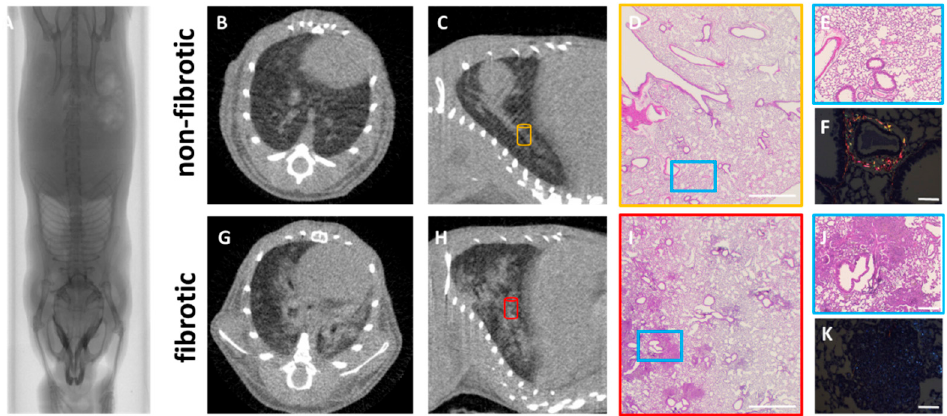
Figure 2. Overview of the use of μ CT and histology in a pre-clinical setting in a silica-induced lung fibrosis mouse model. Mice were oropharyngeally instilled with crystalline silica particles (5 mg/mouse, bottom row) or saline (top row). Whole-body μ CT scan showing the lungs of a mouse instilled with silica to induce fibrosis ( A ). Axial ( B , G ) and sagittal ( C , H ) views of non-fibrotic and fibrotic lungs. Lung fibrosis is confirmed using histology at low magnification (12.5×—scale bar 2 mm) ( D , I ) and high magnification (50×–scale bar 0.5 mm—blue box) from areas indicated with yellow and red cylinders in ( C , H) , showing normal and dense fibrotic regions consisting of silica clustering, cellular infiltration and granuloma formation ( E , J ). Polarization microscopy (scale bar 0.1 mm) ( F , K ) allows visualization and quantification of the maturity of fibrotic lesions and silica clustering.